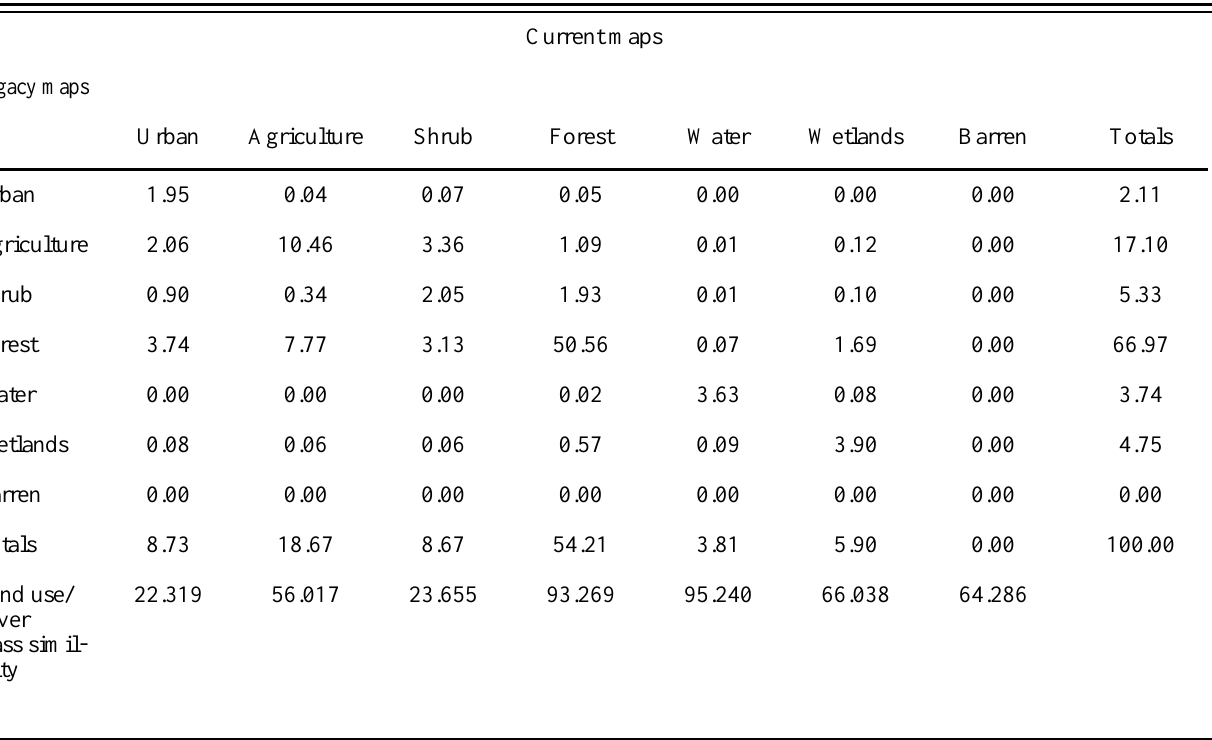
Table 1 . Cross-tabulation between the current and legacy land-use/cover maps expressed in percent of total study area.